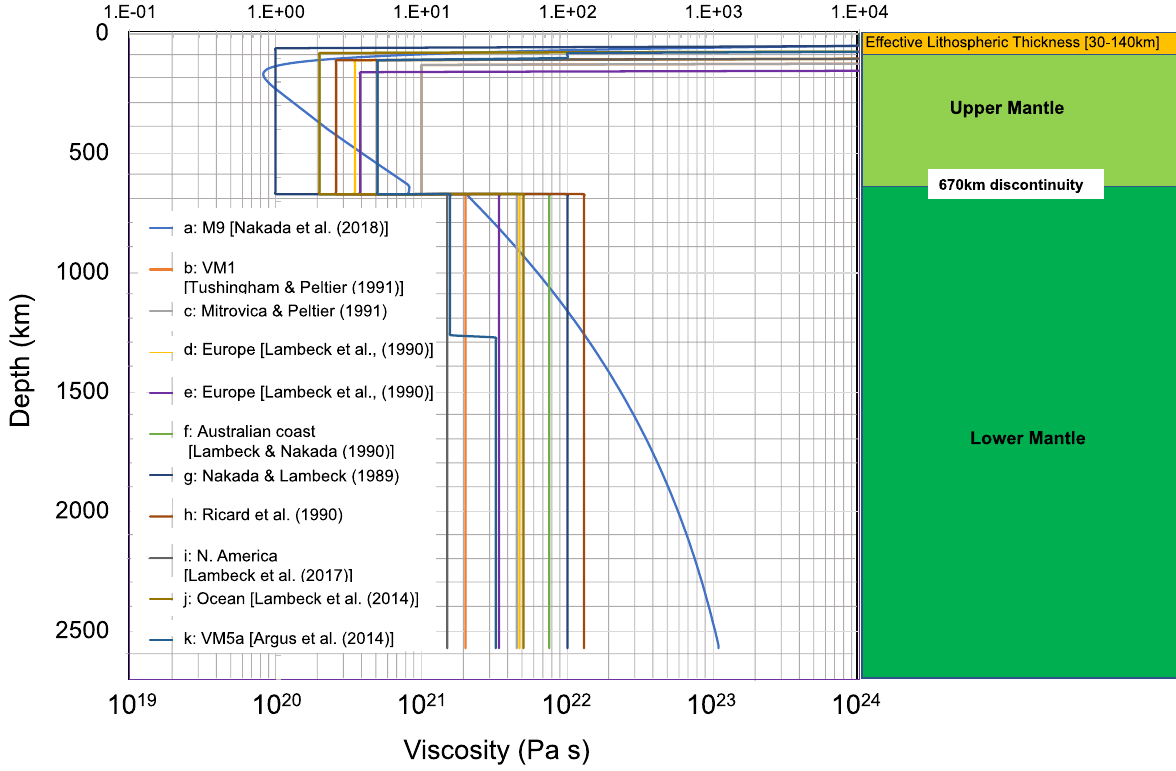
Fig. 7 Example estimates of effective earth response parameters with lithospheric thickness H (km), and viscosities of the upper and lower mantle, respectively (separated at 670 km). The models shown are: a M9 from Nakada et al. (2018), b VM1 from Tushingham and Peltier (1991), c Mitrovica and Peltier (1991), d and e models for Europe from Lambeck et al. (1990), f model for the Australian coast from Lambeck and Nakada (1990), g Nakada and Lambeck (1989), h Ricard et al. (1989), i model for North America from Lambeck et al. (2017), j model for ocean rheology from Lambeck et al. (2014), k model VM5a from Argus et al.